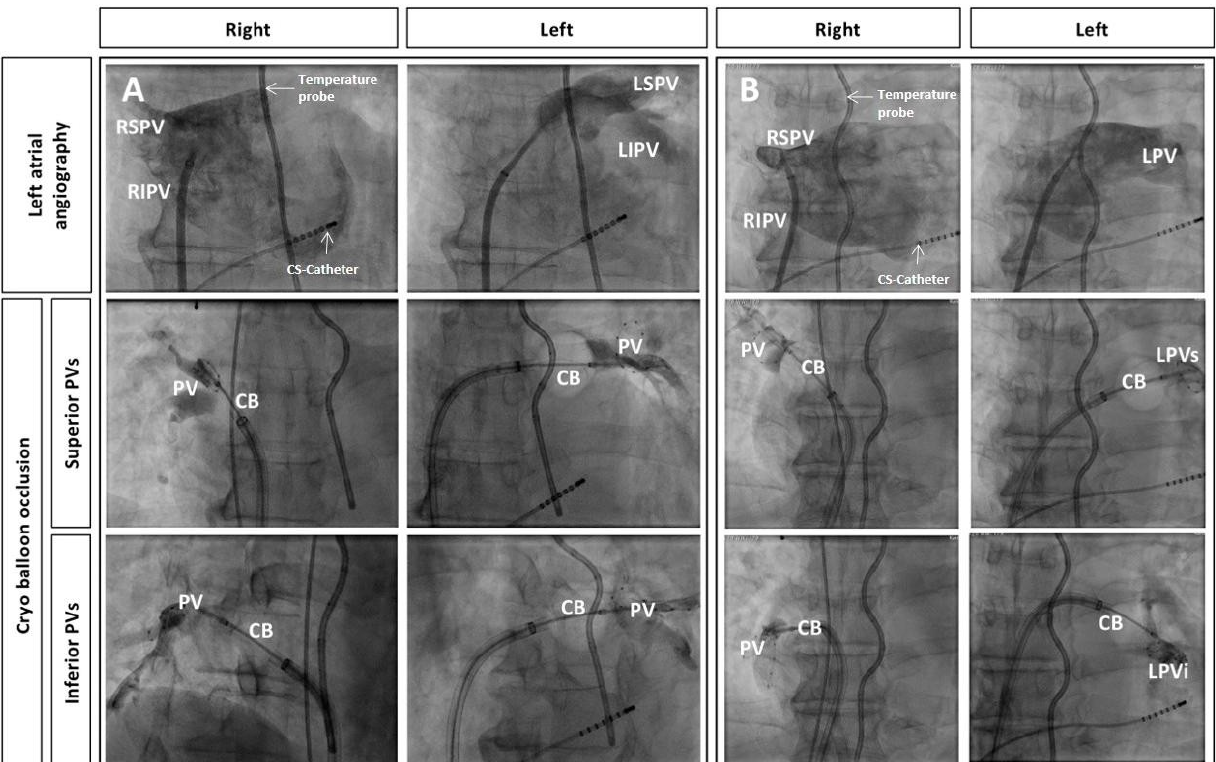
Figure 2. Left atrial angiography and subsequent occlusion of pulmonary veins (PVs) by cryobal- loon (CB) placement, all in anterior-posterior projection. Additionally depicted are the multipolar esophageal temperature probe and the octapolar diagnostic catheter placed in the coronary sinus. ( A ): Normal anatomy, ( B ): Left-sided common ostium (LPV) with superior-inferior (LPVs, LPVi) branches; (LSPV: left superior PV, LIPV: left inferior PV, RSPV: right superior PV, RIPV: right infe- rior PV).